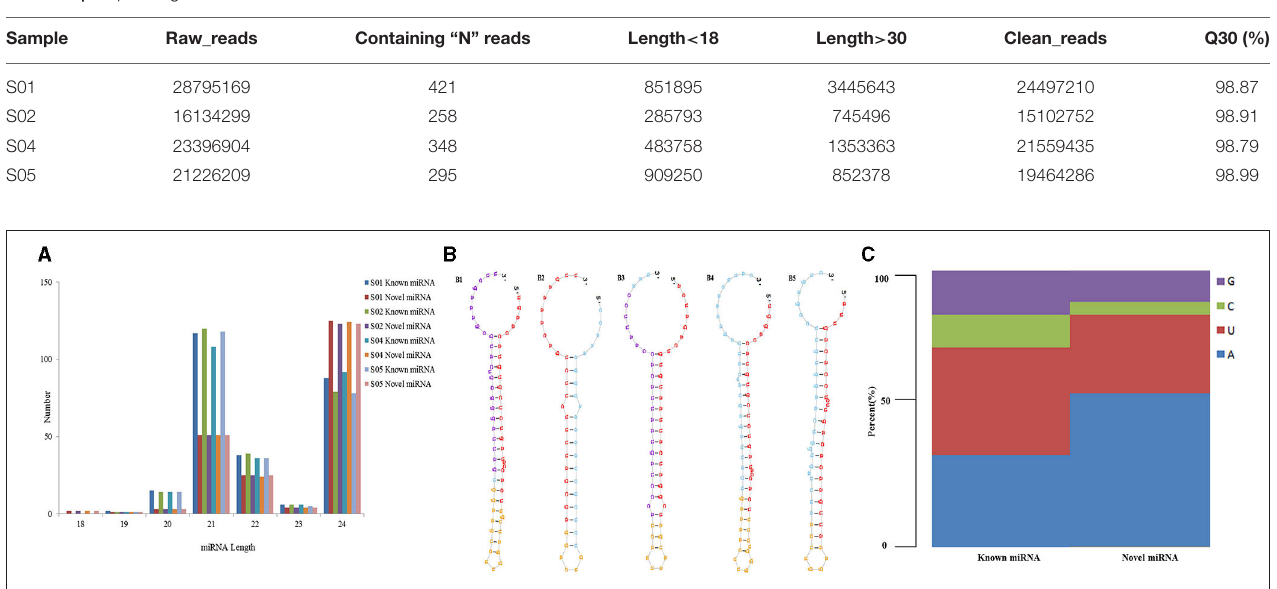
TABLE 1 | Sequencing data statistics table.